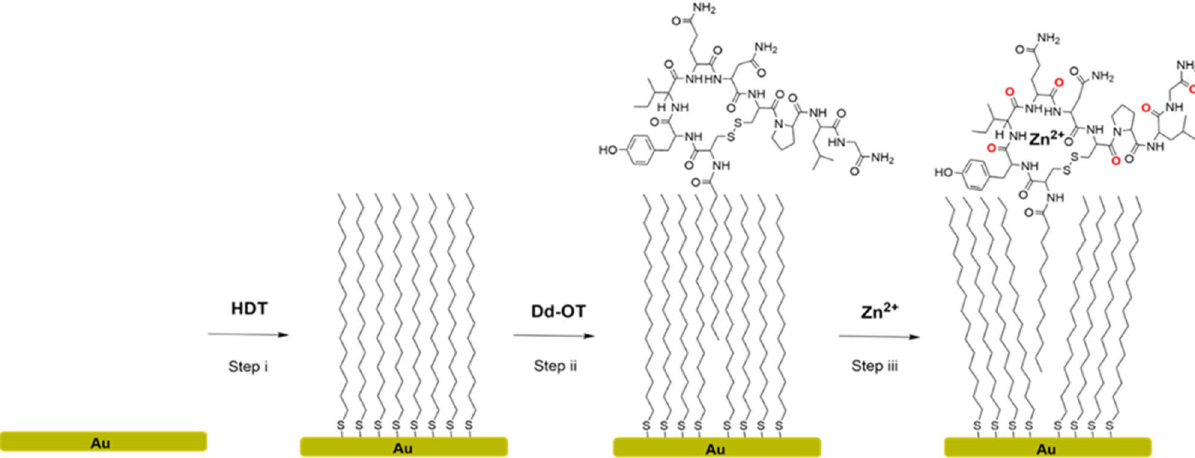
Figure 1. The fabrication steps of the sensing platform. Step i , self-assembly of HDT monolayer. Step ii , intercalation of Dd-OT molecule in the HDT SAM. Step iii , OT-Zn 2+